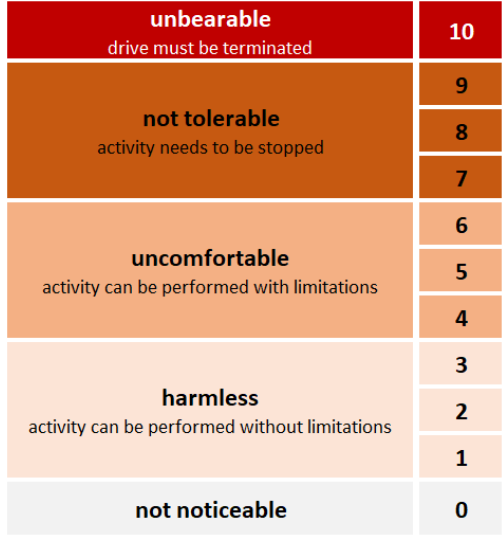
Figure 5. Motion Sickness Task Tolerance (MSTT) Scale used to assess motion sickness at regular intervals during the drive.